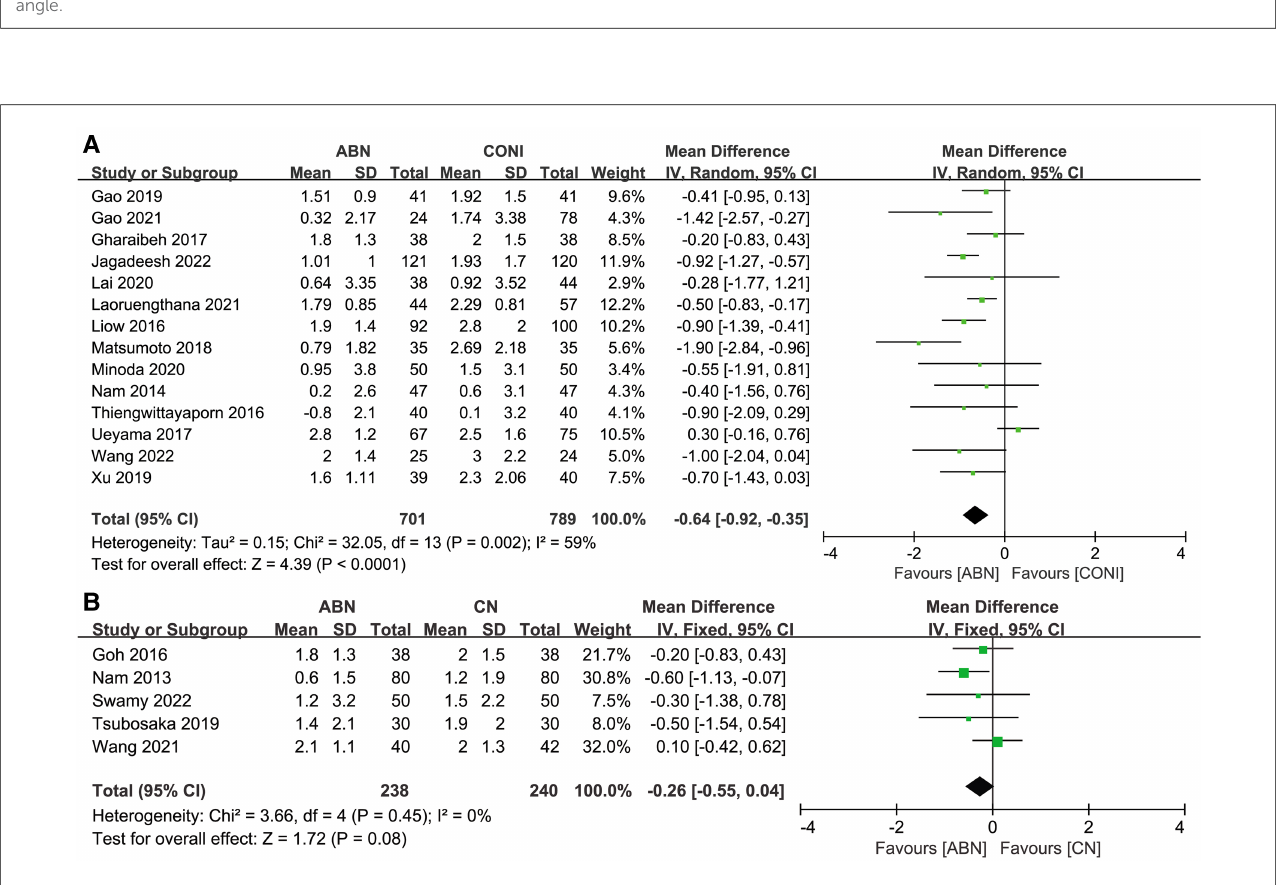
FIGURE 3 Forest plot of hip-knee-ankle (HKA) angle. ( A ) Accelerometer-based navigation (ABN) system vs. conventional instrumentation (CONI); ( B ) ABN system vs. computer navigation (CN)